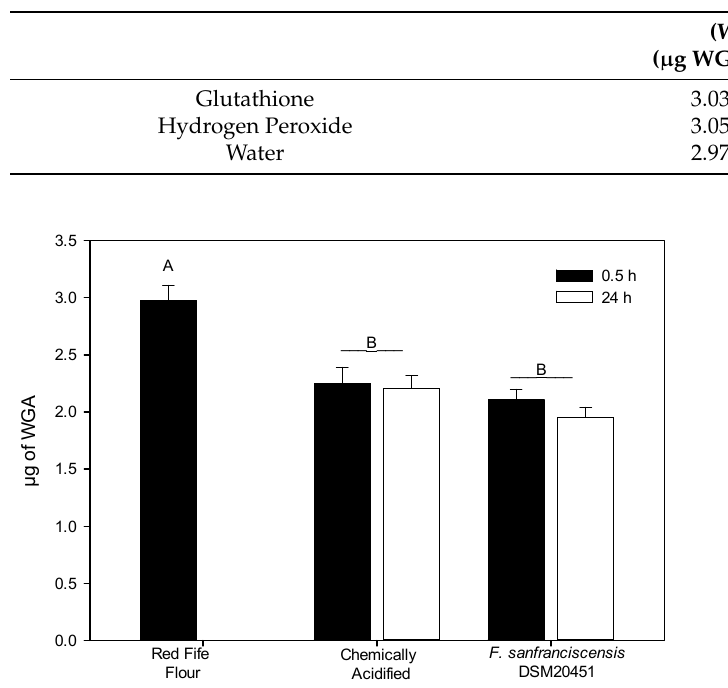
Figure 4. WGA content ( µ g WGA/g flour) of sourdough prepared with Red Fife pure cultivar flour ( n = 3) after 24 h of fermentation with F. sanfranciscensis DSM20451. Chemically acidified doughs and Red Fife flours were used as controls. Samples fermented with different strains or different conditions differ significantly ( p < 0.001) unless they share a common capital letter. Samples fermented with the same strain for 0.5 h or for 24 h were not significantly different ( p > 0.05).